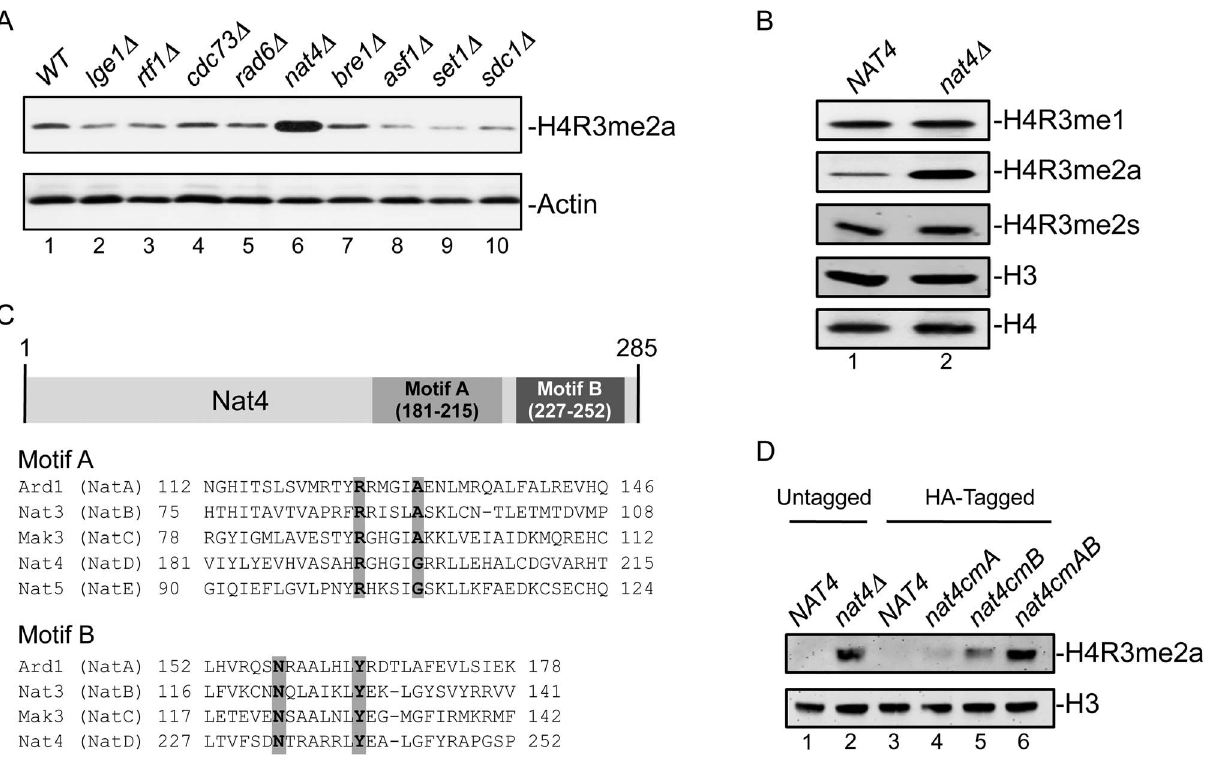
Figure 1. Deletion or inactivation of NAT4 increases the levels of H4R3me2a. (A) Whole cell extracts from the indicated deletion strains were analyzed by western blotting with an antibody against H4R3me2a (top panel). Equal loading was monitored using an antibody against actin (bottom panel). (B) Whole cell extracts from a wild-type strain ( NAT4 , lane1) and another one carrying a NAT4 deletion ( nat4 D , lane 2) were analyzed using antibodies against various H4R3 methylation states. Equal loading was monitored with H3 and H4 antibodies. (C) Sequence alignment of the catalytic motifs A and B of the five S. cerevisiae N-alpha acetyltransferases (NATs). The residues that were mutated within each motif to generate the Nat4 catalytic mutants are highlighted in grey. (D) Whole cell extracts from strains containing wild-type NAT4 (lanes 1 and 3)) and different NAT4 mutants (lanes 2, 4, 5 and 6) were analyzed by western blotting using antibodies against H4R3me2a (top panel) and H3 (bottom panel). The strain in lane 2 represents a Nat4 deletion strain. All catalytic mutant strains (lanes 4–6) have a C-terminal hemagglutinin (HA) tag. The strain containing the mutations within motif A is designated as nat4cmA (lane 4), the one with mutations in motif B is nat4cmB (lane 5) and the one with mutations in both motifs is noted as nat4cmAB (lane 6). Their equivalent wild-type strain contains only the C-terminal HA-tag (lane